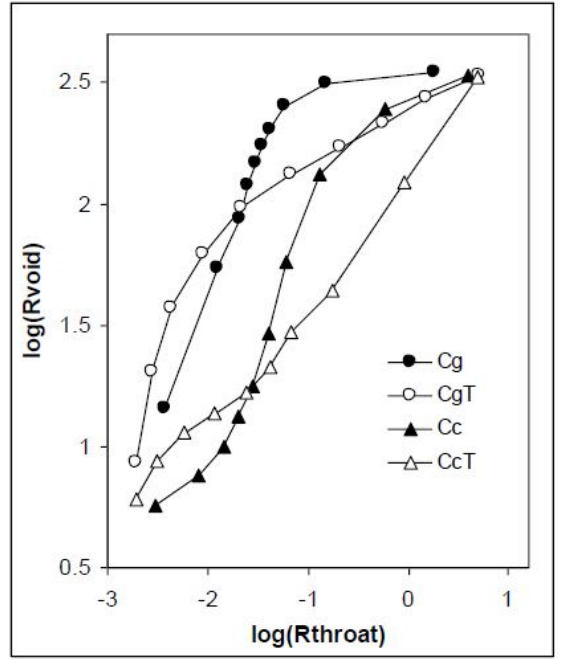
Figure 5. Dependence of pore void to pore throat radii for the studied concretes before and after heating. Data in logarithmic scales are depicted.